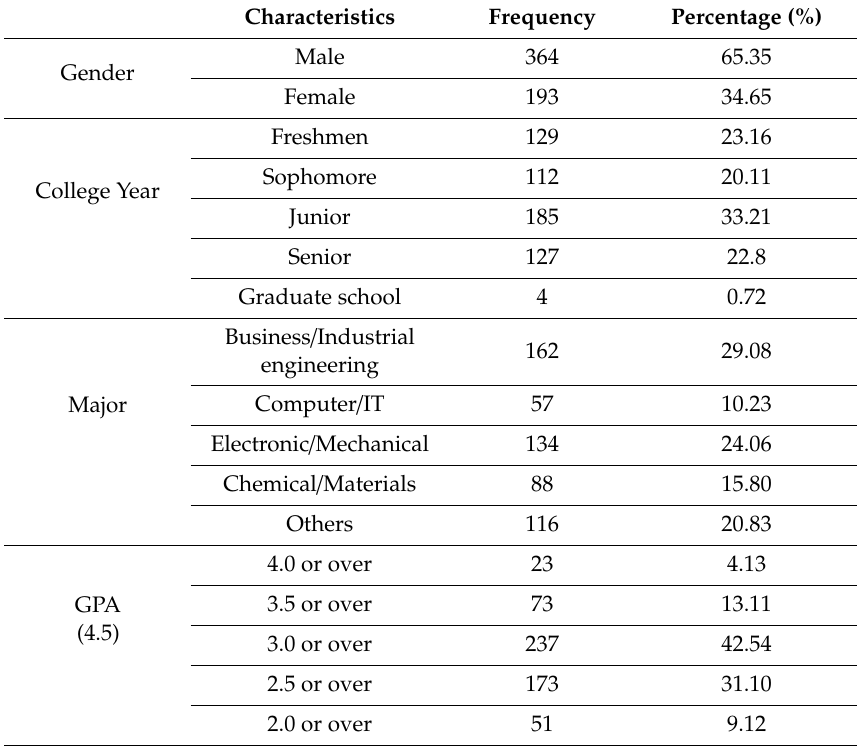
Table 2. Sample Distribution (N = 557). GPA: grade point average, IT: information technology. Characteristics